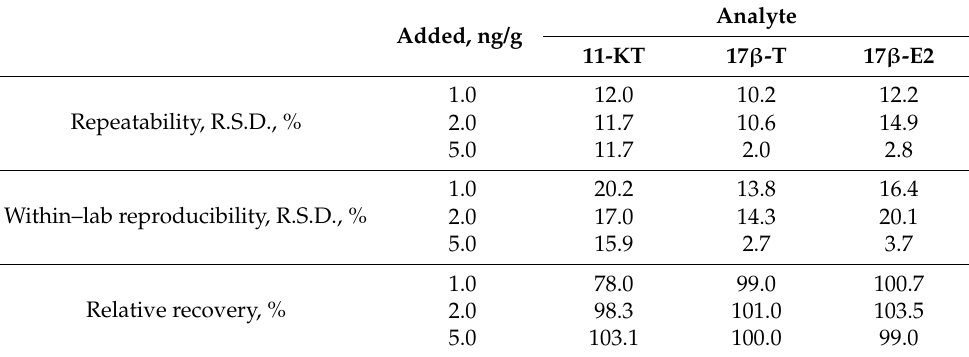
Table 5. Repeatability, within-laboratory reproducibility and relative recovery in evaluated female gonad